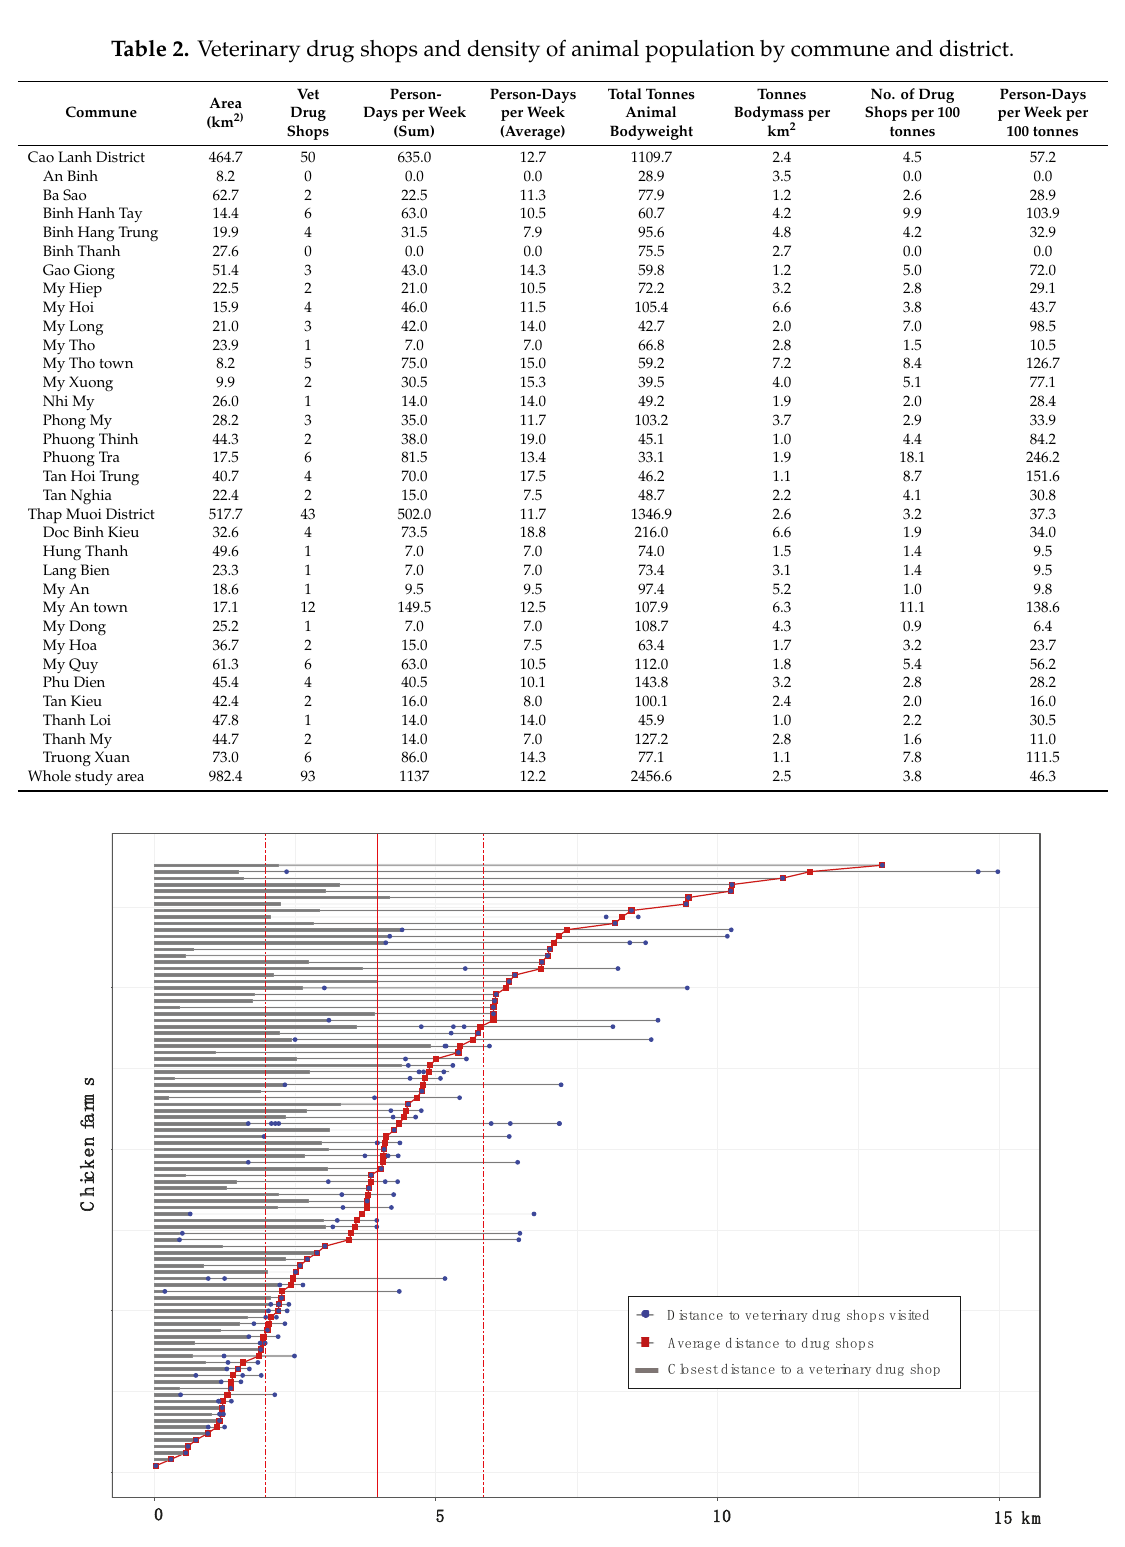
No. of Drug Tonnes Bodymass per Shops per 100 km 2 tonnes